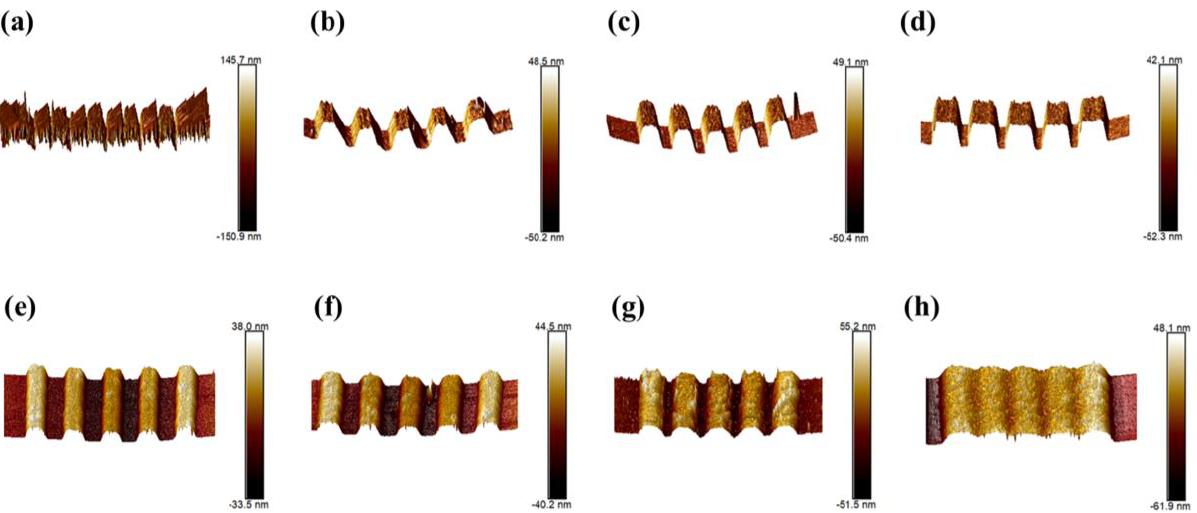
Figure 5. AFM images of lithographic patterning under different baking temperatures ( a – d ). Soft– bake: 90 °C, 110 °C, 130 °C, 150 °C; ( e – h ) Post–exposure bake: 80 °C, 100 °C, 120 °C, 140 °C.